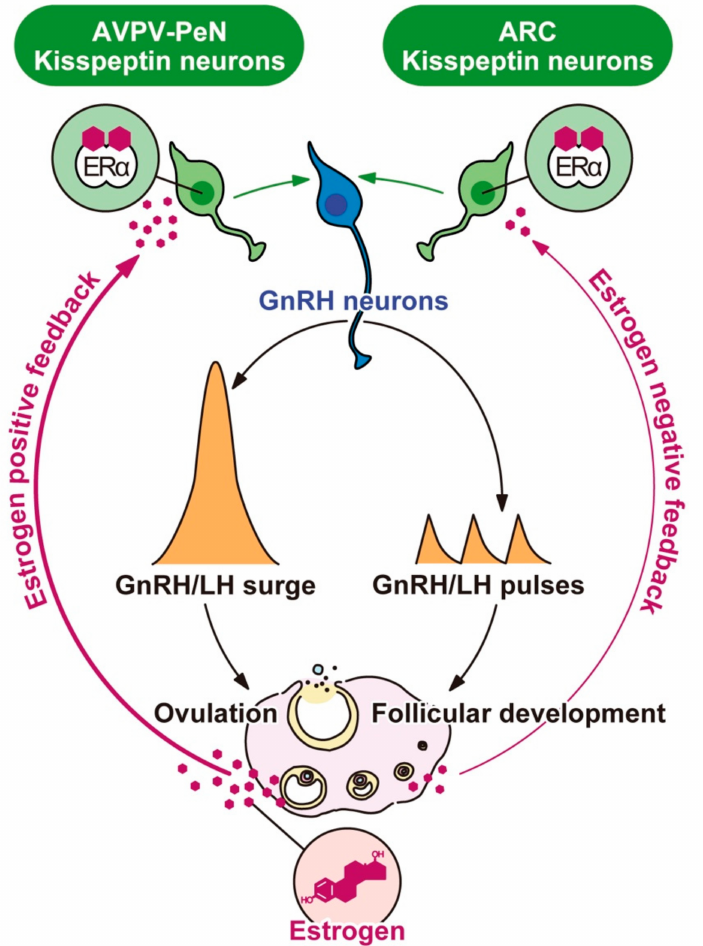
Figure 1. Central mechanisms underlying the negative and positive feedback actions of estrogen on pulsatile and surge modes of gonadotropin-releasing hormone (GnRH)/luteinizing hormone (LH) release in female rodents. Estrogen production along with follicular development is stimulated by GnRH/gonadotropin pulses. During the follicular development period, low levels of circulating estrogen fine-tune GnRH/H pulses via the negative feedback action of estrogen. The estrogen negative feedback action is considered to be mediated by estrogen receptor α (ER α )-expressing kisspeptin neurons located in the arcuate nucleus (ARC). Estrogen production and release gradually increase along with the follicular development, and consequent high levels of circulating estrogen derived from mature follicles, in turn, induce GnRH/LH surge and hence ovulation via the positive feedback action of estrogen. The estrogen positive feedback action is likely mediated by ER α - expressing kisspeptin neurons located in the anteroventral periventricular nucleus–periventricular nucleus continuum